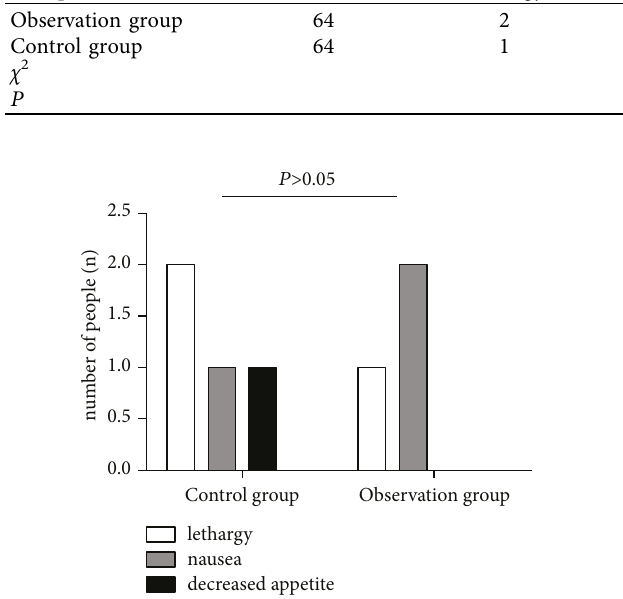
Figure 5: Comparison of adverse reactions between the two groups.